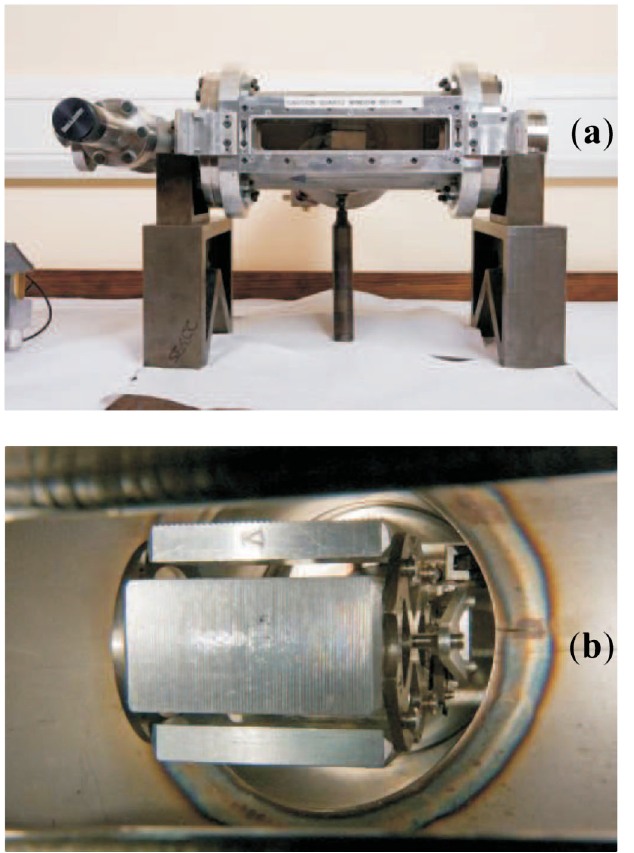
system.FIG. 2. (Color) (a) The vacuum chamber with the crystalline quartz window and (b) one of the gratings, inside the chamber.